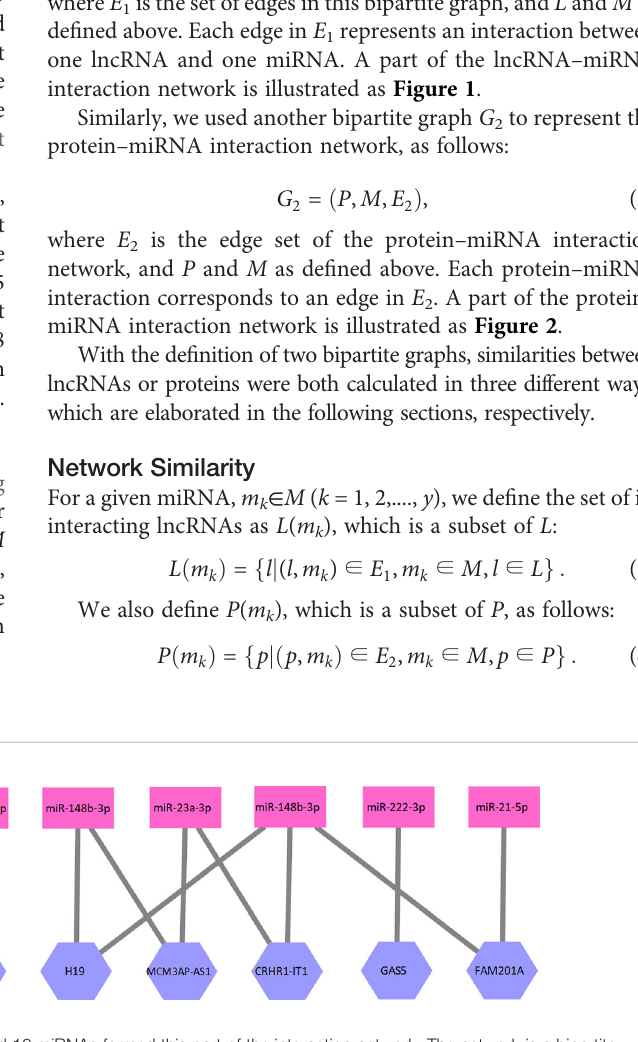
FIGURE1 | A part of the lncRNA – miRNA interaction network. Ten lncRNAs and 10 miRNAs formed this part of the interaction network. The network is a bipartite graph. One lncRNA can interact with multiple miRNA and vice versa.